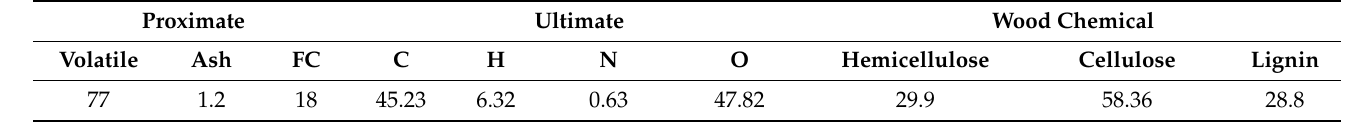
Table 1. The raw materials characterization: proximate, ultimate, and chemical. Proximate Ultimate Wood Chemical